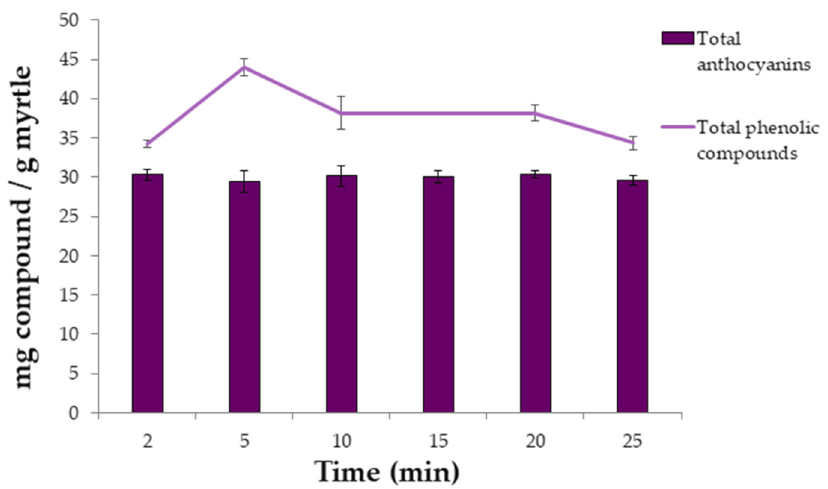
Figure 3. Recovery of anthocyanins (mg · g − 1 ) and total phenolic compounds (mg · g − 1 ) using different extraction times ( n = 3 ).